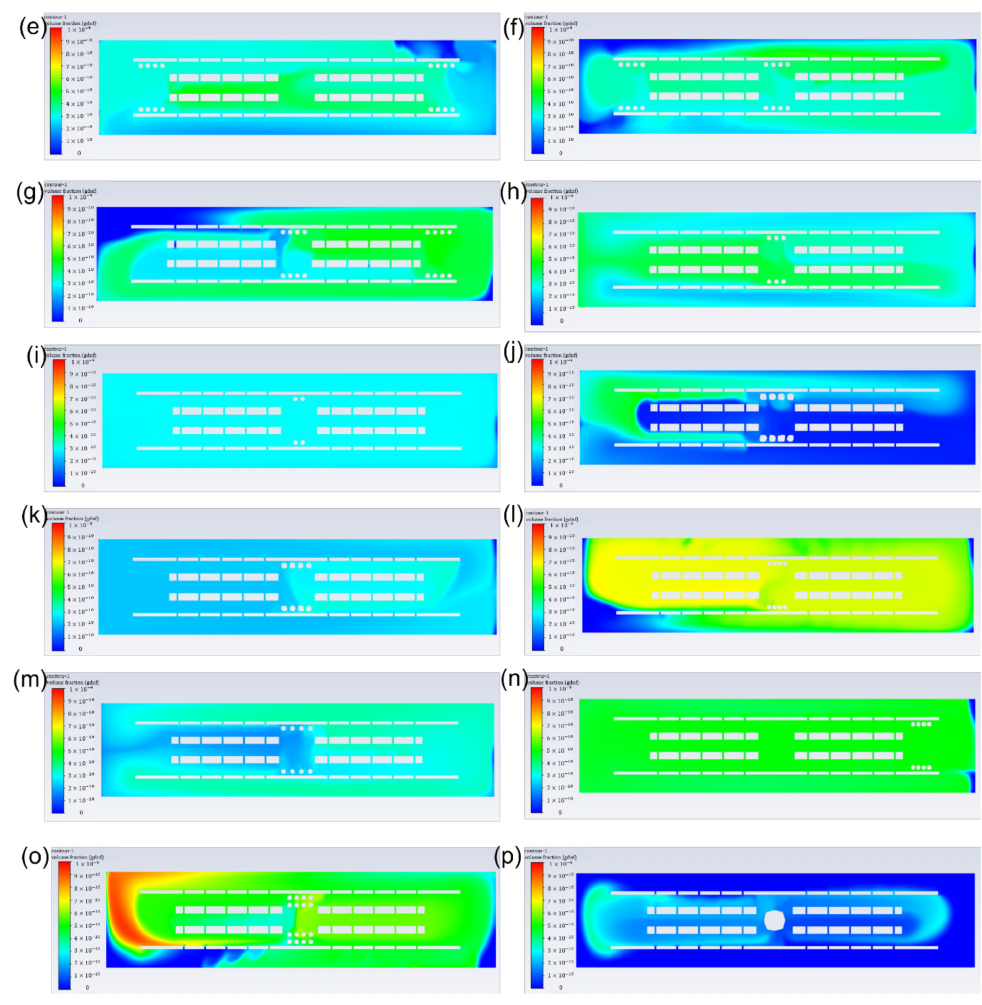
Figure 6. GDNF distribution of different drug release systems under the assumption of